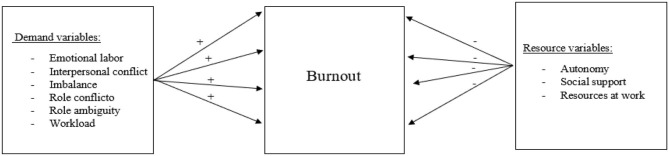
Hypothesis 1 and 2.